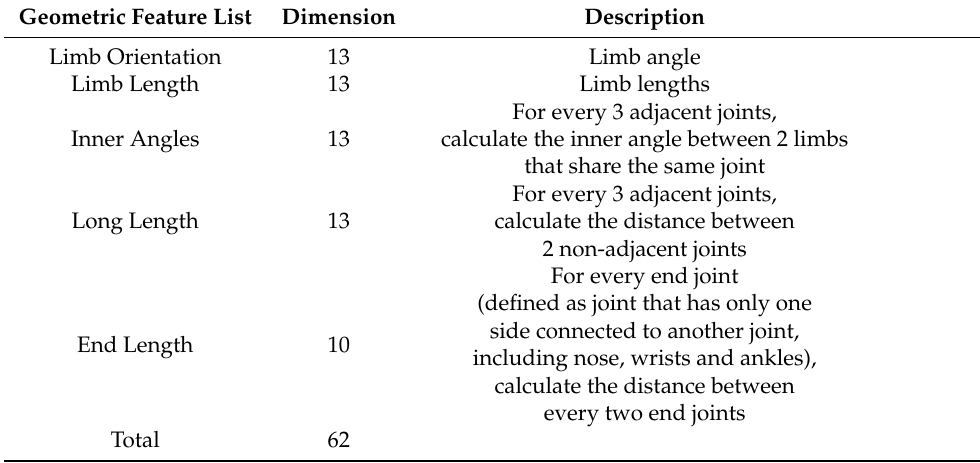
Table 1. Geometric